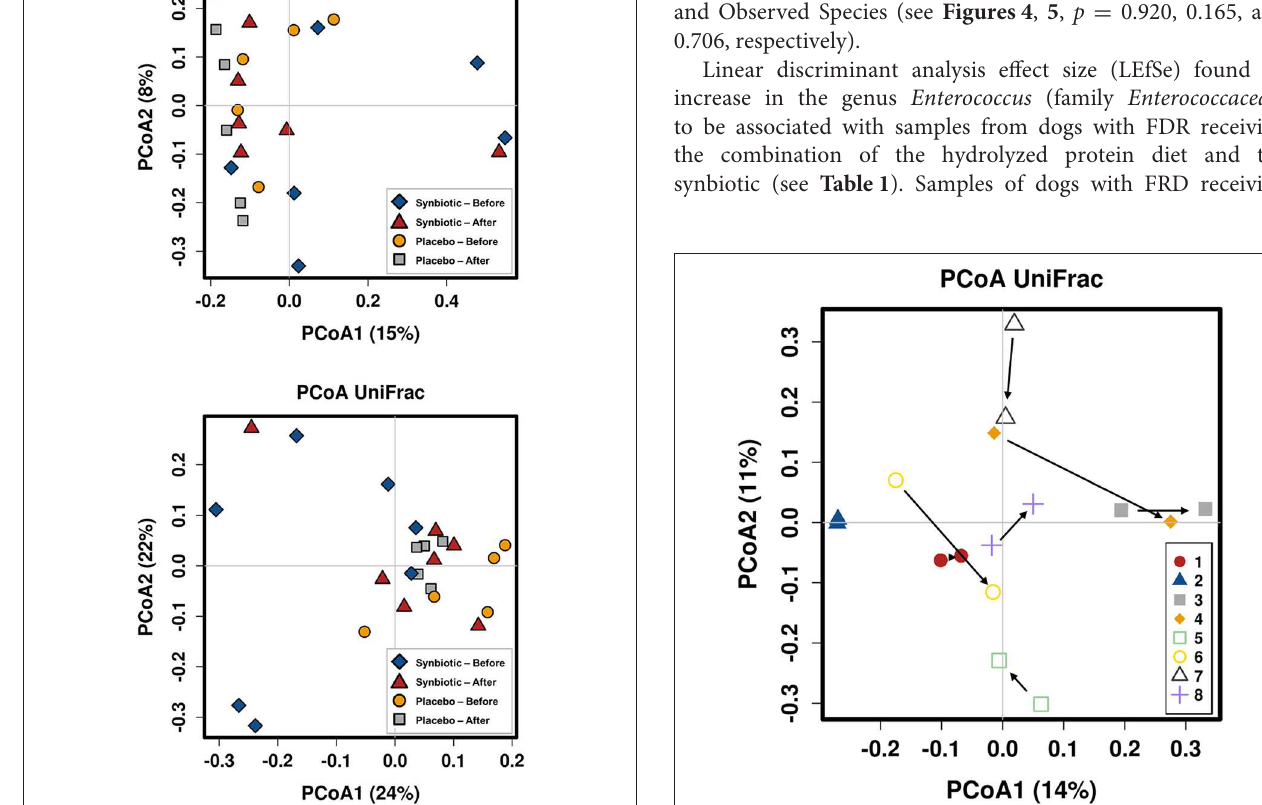
FIGURE 1 | Principal coordinate analysis of the fecal microbiota from dogs with food-responsive chronic enteropathy. Beta diversity was calculated based on unweighted UniFrac distances ( A , p = 0.205) and weighted UniFrac distances ( B , p = 0.107).